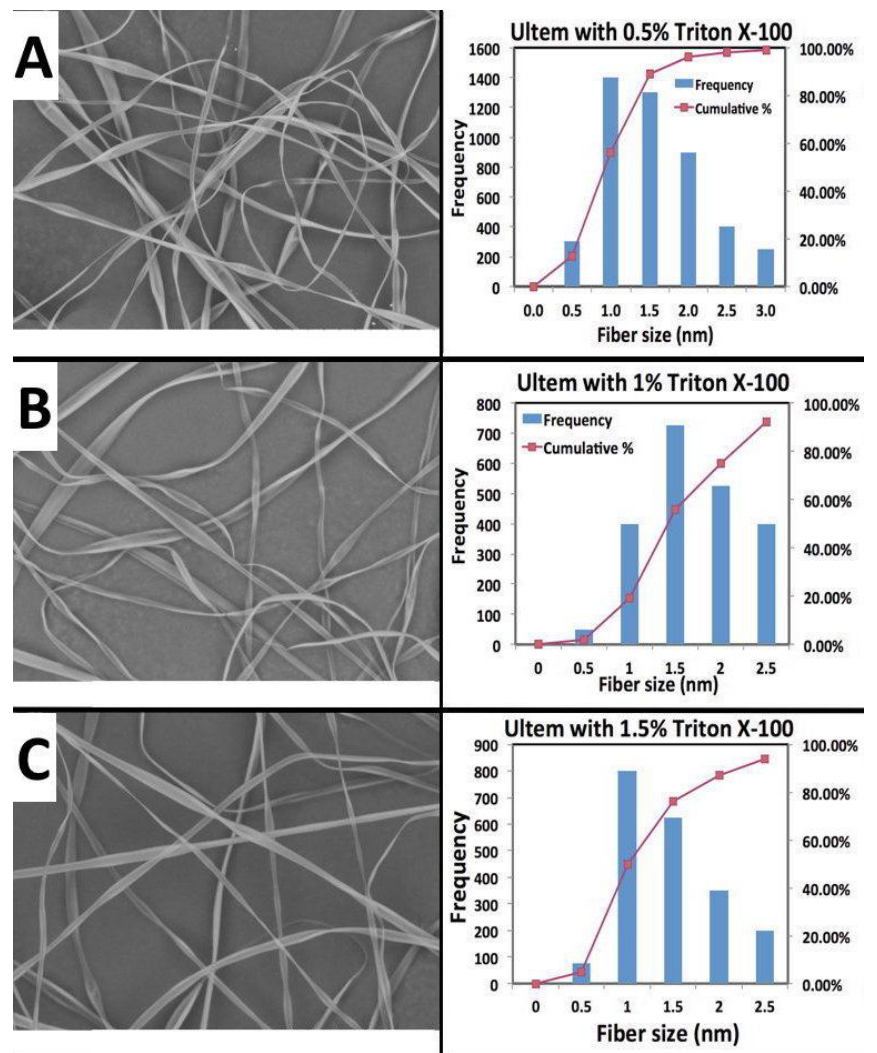
Figure 6. SEM images of 14 wt. % PEI and ( A ) 0.5% Triton X-100, ( B ), 1% Triton X-100, ( C ) 1.5% Triton X-100 surfactant addition electrospun fibers at 20 kV/20 cm and 10 µl/min.